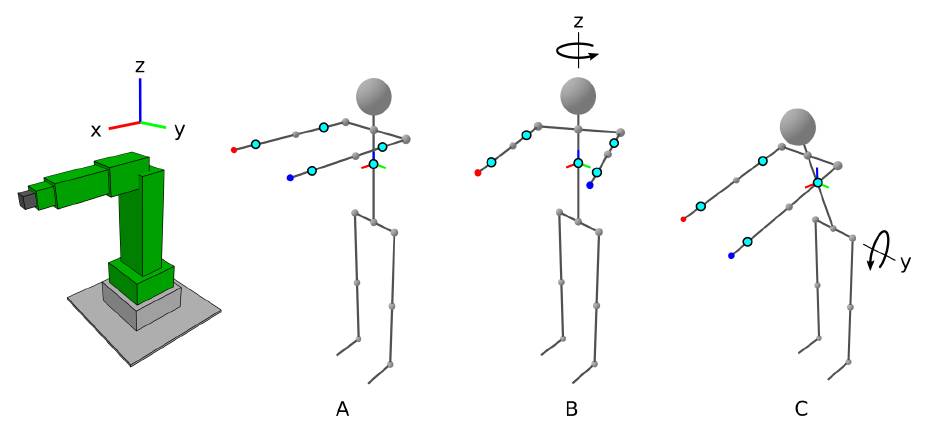
Figure 4. The calibration procedure. ( A ) The starting position of the operator, ( B ) the position for determining the Z axis and ( C ) the position for determining the X and Y